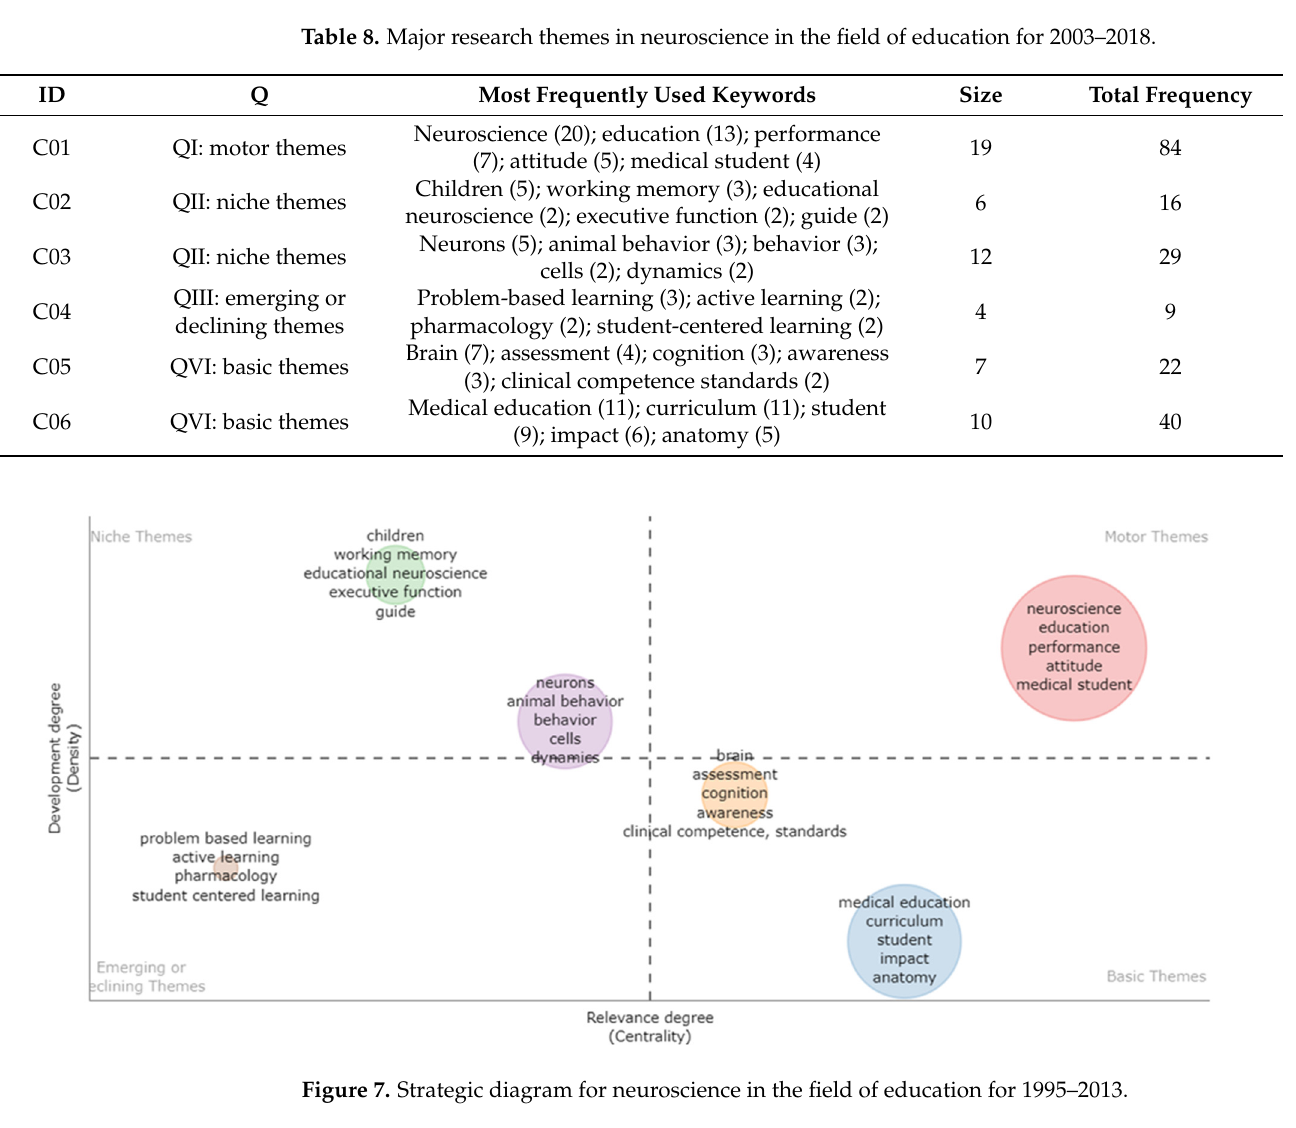
Table 9. Major research themes in neuroscience in the field of education for